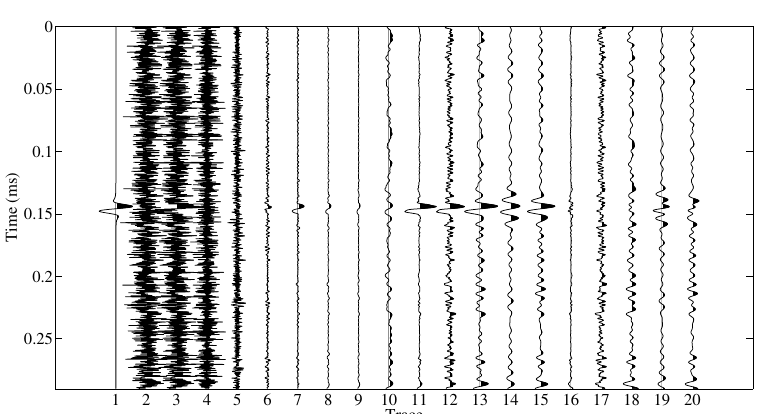
Figure 4. The first synthetic example. From left to right: the 1st trace: signal, the 2nd trace: Gaussian noise, the 3th trace: signal + Gaussian noise (input data), the 4th–10th traces: seven multi-scale components, the 11th trace: orthogonalized morphological reconstruction, the 12th trace: conventional morphological reconstruction, the 13th trace: result using band-pass filtering with trapezoidal band 10–20–180–190 Hz, the 14th trace: result using band-pass filtering with trapezoidal band 70–80–120–130 Hz, the 15th trace: result using band-pass filtering with trapezoidal band 60–70–170–180 Hz, the 16th–20th traces: errors of two reconstructions and three filtered